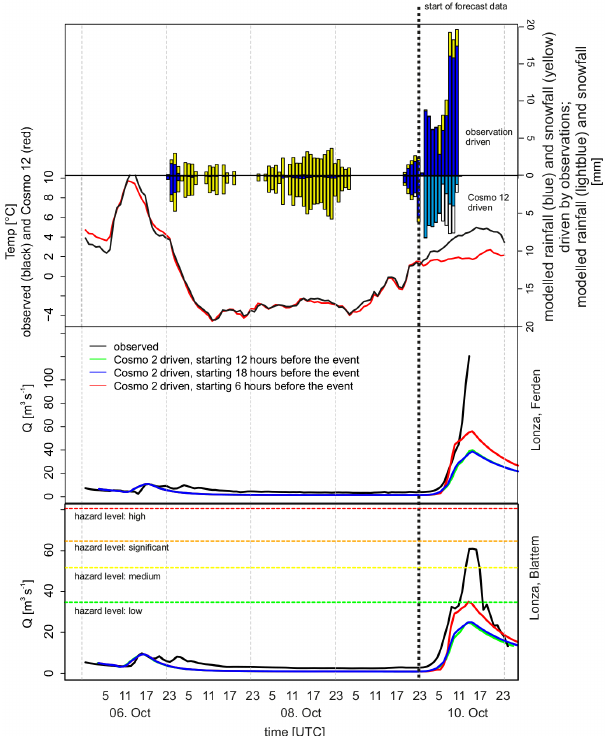
Figure 11. Simulated discharge at Lonza, Ferden, and Lonza, Blat- ten, using the recalibrated hydrological model (V4) with COSMO-2 data 6, 12, and 18h in advance. The temperature and the solid and liquid precipitation are average values for the entire valley taken from COSMO-2, 12h in advance. The blue and yellow bars and black line indicate observed rain, snow, and temperature of the re- fined meteorology, respectively. Hazard levels are official hazard levels corresponding to a 2, 10, 30, and 100-year